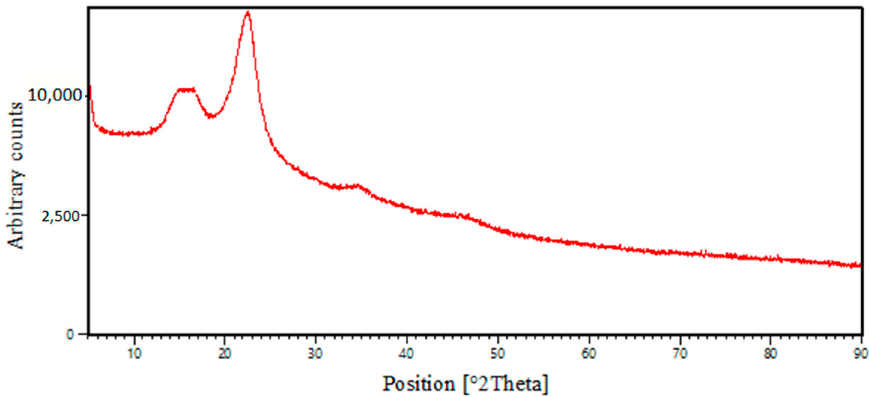
Figure 2. Alfa fiber X-ray diffractogram.